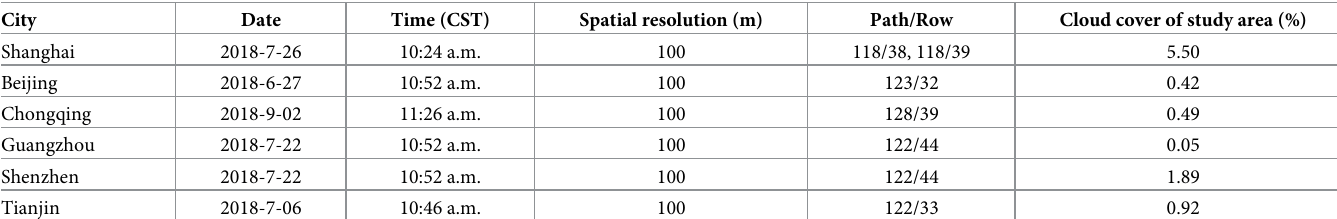
Table 2. Landsat 8 TIRS